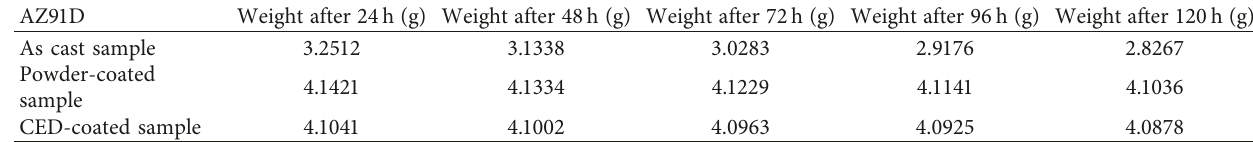
Table 9: Weight reduction of samples after 24, 48, 72, 96, and 120 hours.